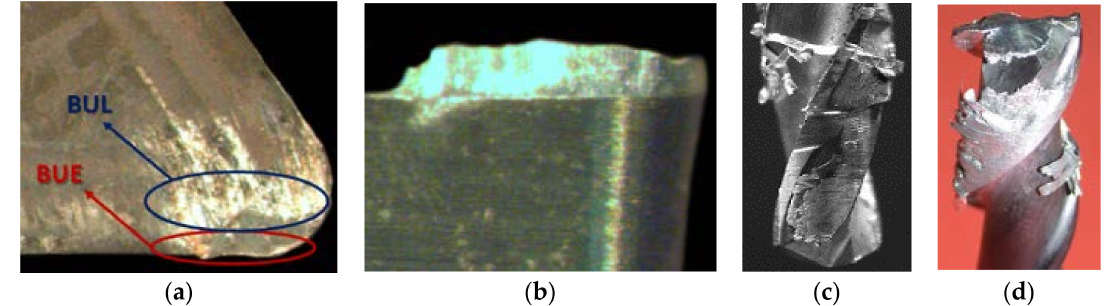
Figure 1. Cutting tools affected by adhesive wear mechanism in the machining of Al alloys: ( a ) turning insert tool; ( b ) detail of the adhered material thickness; ( c ) drilling tool; ( d ) milling tool for radial operations.